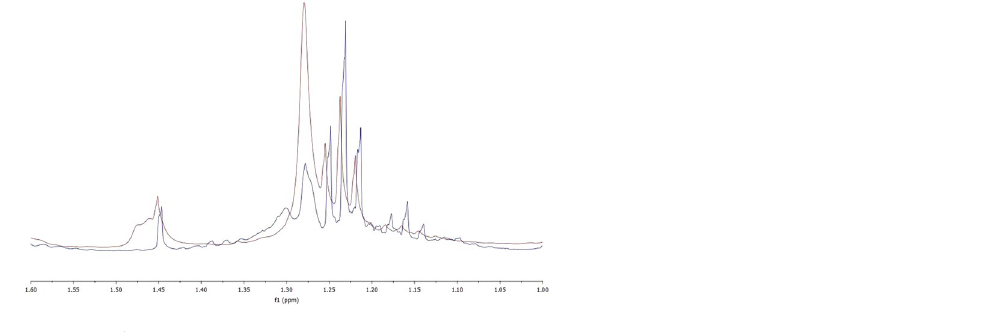
Figure 3. 1 H-NMR spectra of light oil from test 3 (red) and test 7